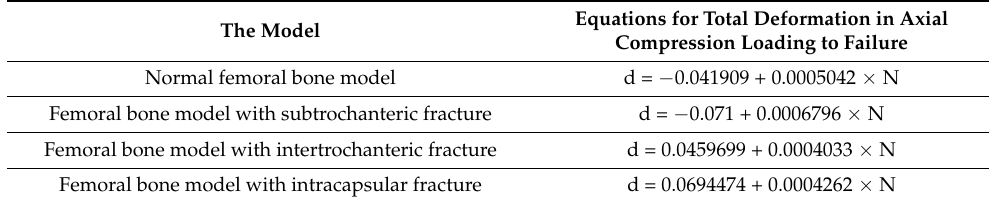
Table 4. Equations for total deformation in axial compression loading to failure.